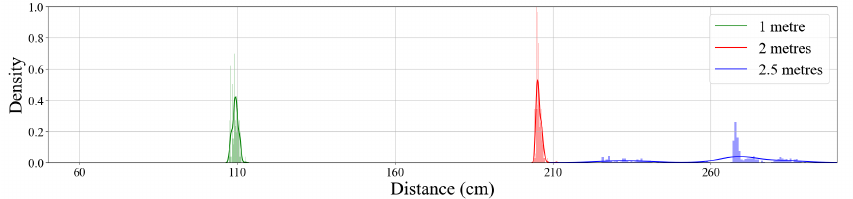
Figure 21. Distribution plot for samples measured at two different distance intervals to the car.